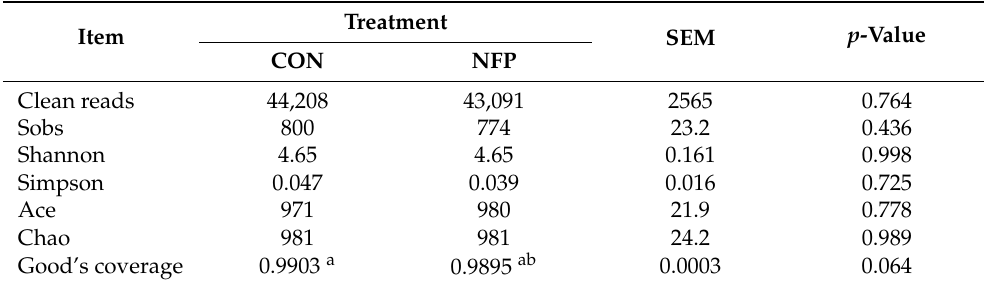
Figure 1. Common and distinctive bacterial OTU between the samples by Venn’s diagram in Exp. 2 ( n = 7). Table 7. Number of clean reads, operational taxonomic units (OTU) and alpha diversity indices of ruminal bacteria in Exp. 2.